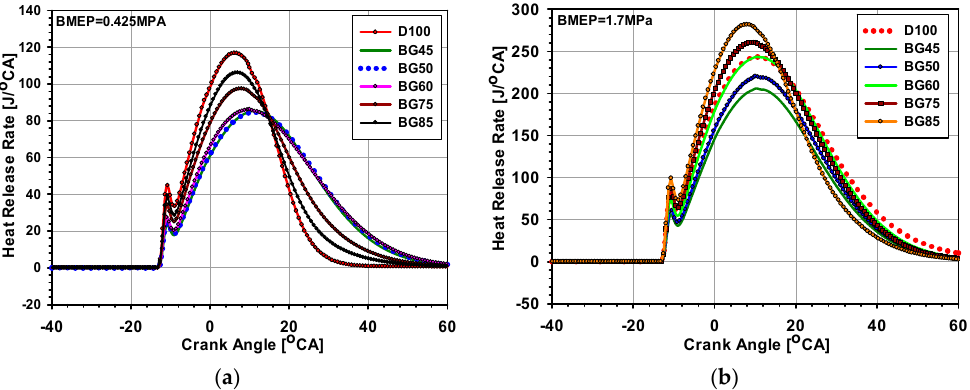
Figure 10. Variations of HRR with crank angle for diesel and biogas-diesel fuels. ( a ) BMEP = 0.45MPa, ( b ) BMEP = 1.7MPa.